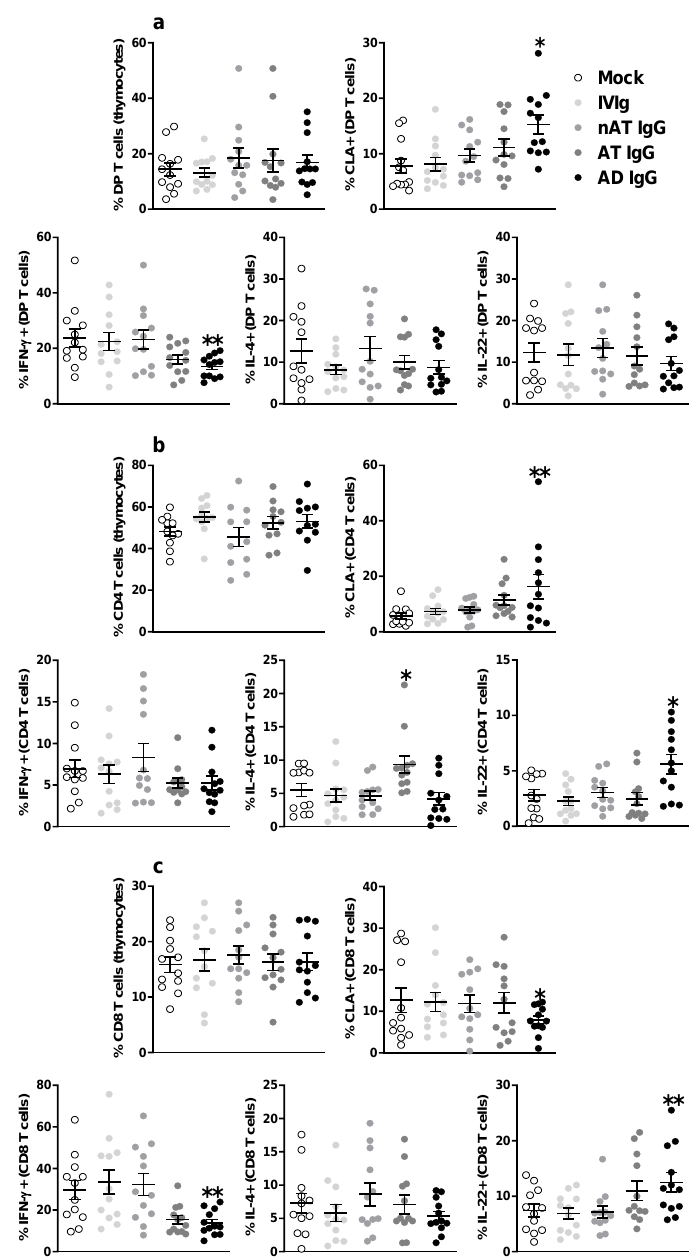
Figure 1. Effect of purified adult AD IgG on infant non-atopic intra-thymic T cells. Thymocytes from children under seven days old (n = 12) were evaluated after six days in culture in RPMI medium supplemented with FCS in the absence (mock) or presence of 100 µ g/mL of commercially used purified IgG (IVIg), IgG purified from non-atopic individuals (nAT), IgG purified from atopic individuals (AT) or IgG purified from adult AD patients (AD). The frequencies of DP T, CD4 T, and CD8 T cells were evaluated ( a ), and the expression of CLA ( b ) or intracellular IFN- γ , IL-4, and IL-22 ( c ) were evaluated in these populations by flow cytometry. Each dot represents the value obtained from a different thymus. Bold lines represent the mean ± standard error. * p ≤ 0.05 compared to all other conditions; ** p ≤ 0.05 when compared to Mock. IVIg and nAT conditions. The absence of markings indicates that there was no statistical difference between the evaluated groups ( p >